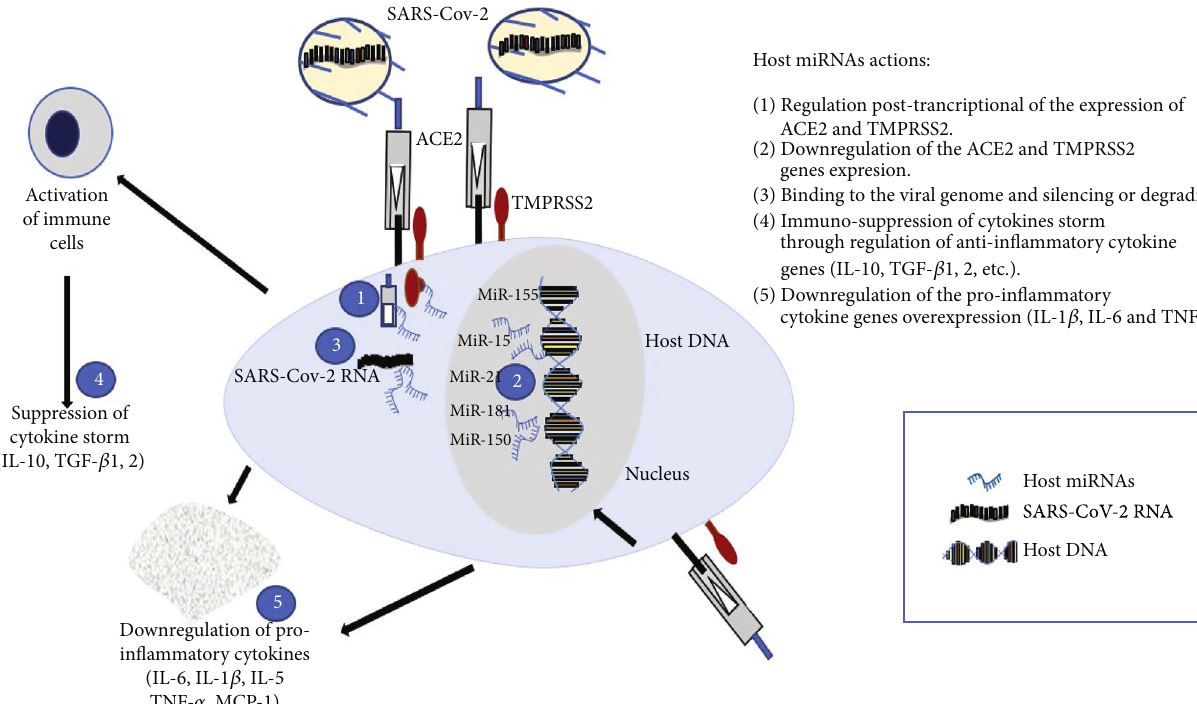
Figure 1: Plausible host miRNA action modes in SARS-CoV-2 infection. Host miRNAs may regulate the COVID-19 infection through 5 processes: 1 — posttranscriptional regulation of the expression of ACE2 and TMPRSS2, 2 — downregulation of the ACE2 and TMPRSS2 gene expression, 3 — binding to the viral genome and silencing or degrading it, 4 — immunosuppression of cytokine storm through regulation of anti-in fl ammatory cytokine genes (IL-10, TGF- β 1,2, etc.), and 5 — downregulation of the proin fl ammatory cytokine gene overexpression (IL-1 β , IL-6, and TNF- α ). Abbreviations: ACE2: angiotensin-converting enzyme; MiR: microRNA;